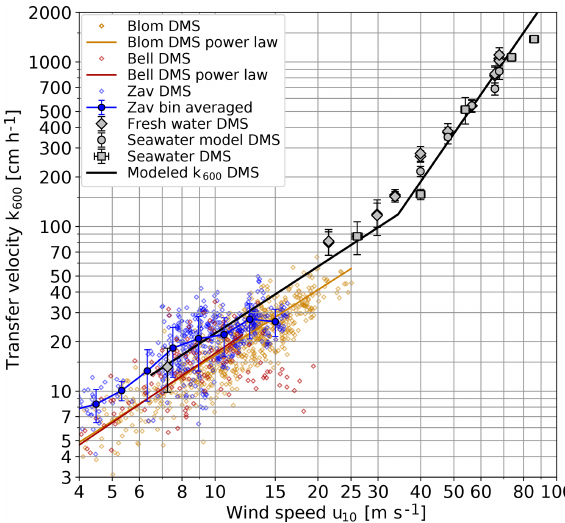
Figure 11. Comparison of oxygen gas transfer velocities inferred from the lab measurements presented in this paper with the field data by McNeil and D’Asaro (2007); both are Schmidt number scaled to k 600